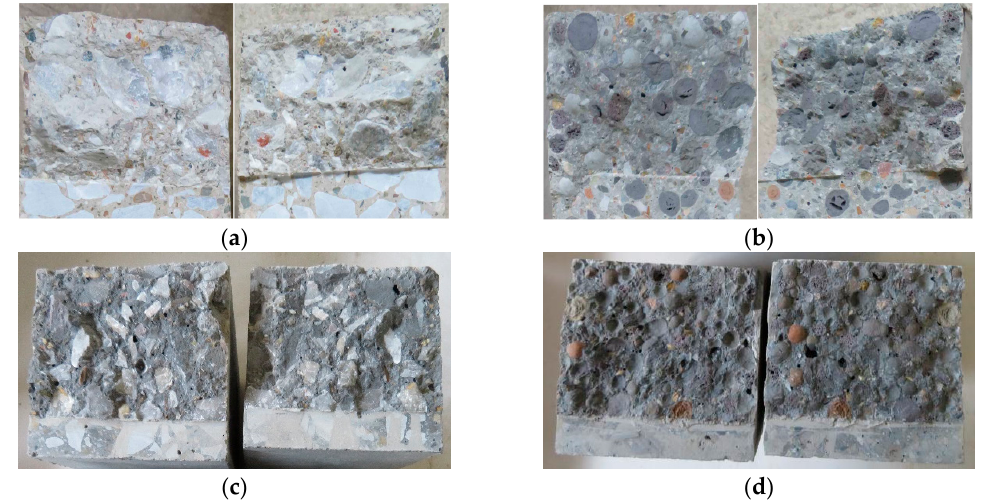
Figure 10. The typical fracture planes of four types of concrete with a similar compressive strength: ( a ) NOPC; ( b ) LOPC; ( c ) NAAC; ( d ) LAAC.